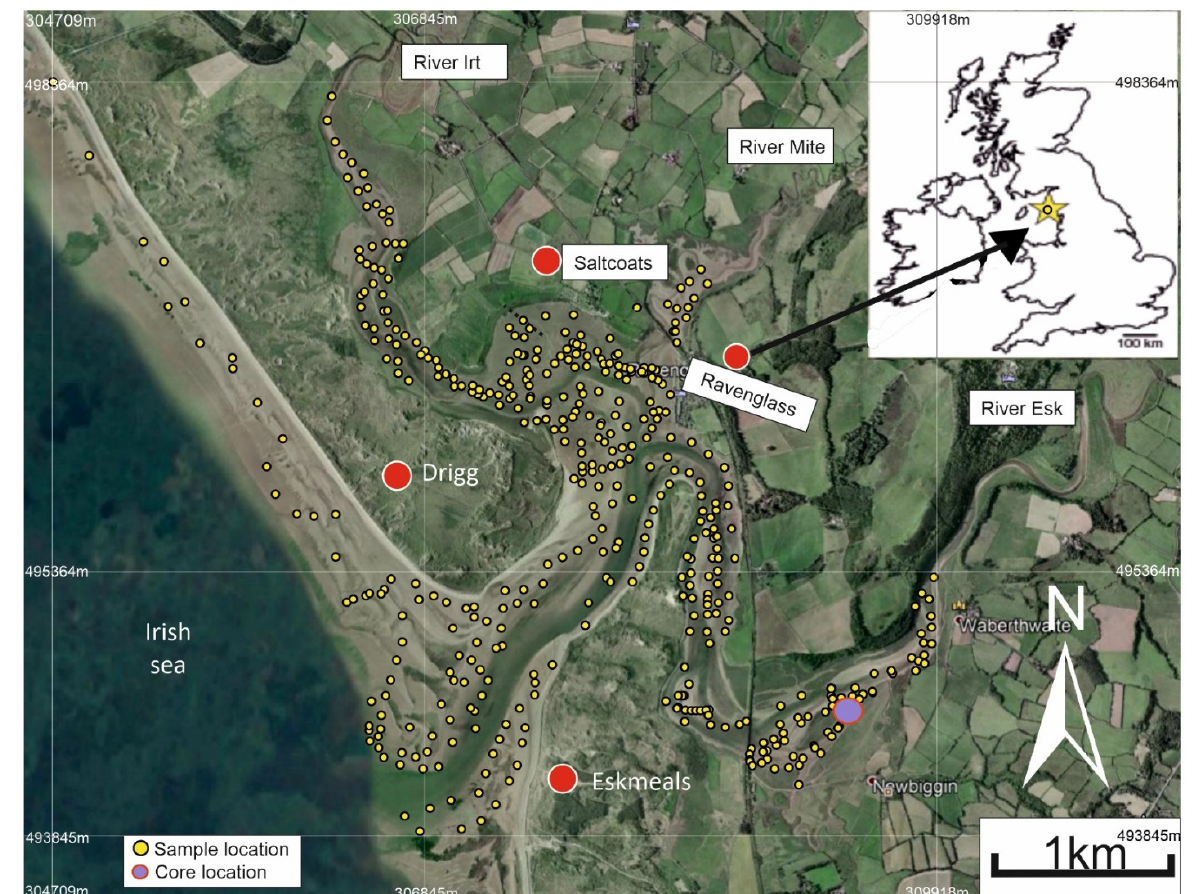
Figure 1. Location map of the Ravenglass Estuary, north-west England with an inset map showing the location of the estuary in the UK. The small yellow dots shows the distribution of surface-sediment sample site (<2 cm) used for XRF analysis and the larger purple dot shows the location of the geotechnical core.